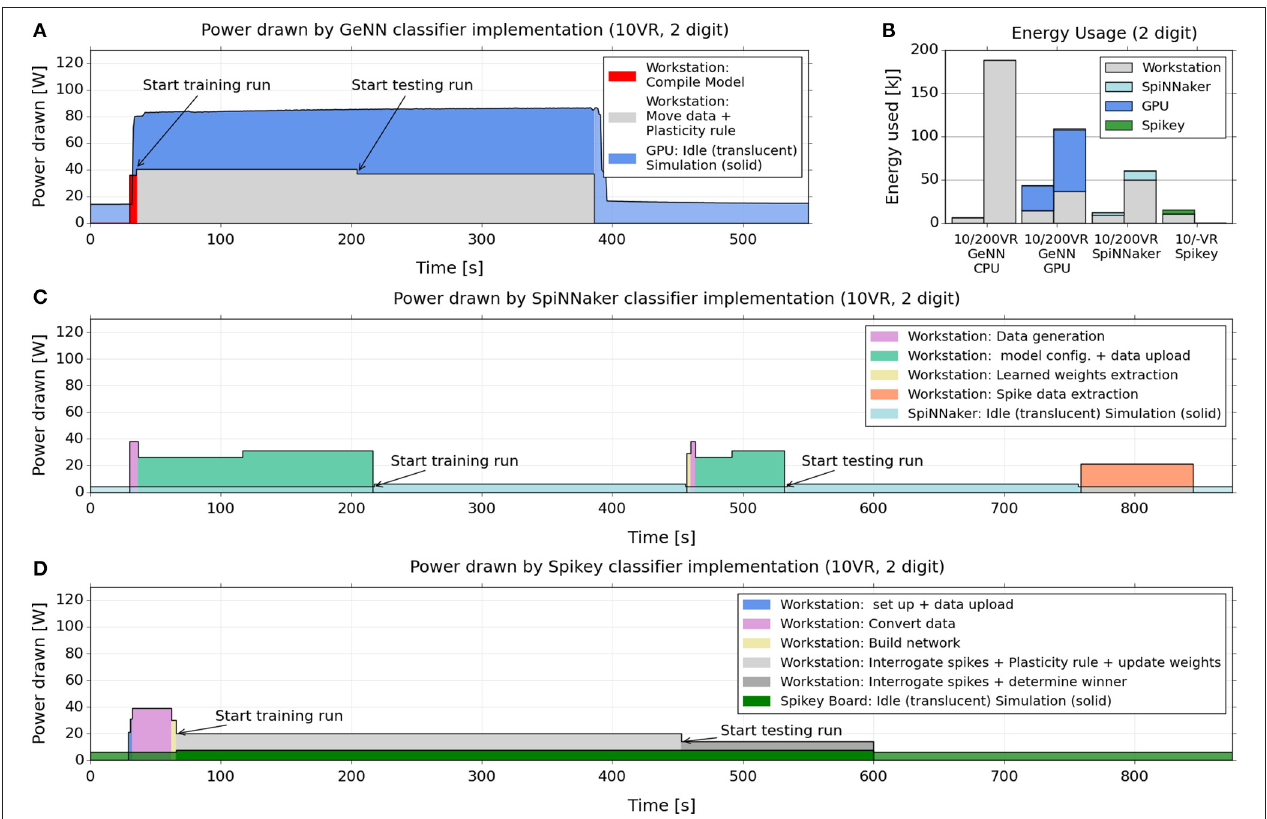
FIGURE 5 | Electrical power drawn and energy used by GeNN, SpiNNaker and Spikey across training and testing when classifying 2 digits with 10VRs. (A,C,D) power consumption across the course of training and testing of a 10VR classifier for 2 MNIST digits (5,7), 1000 samples per digit. The graphs compare the implementations on the GeNN (A) , SpiNNaker (C) , and Spikey (D) platforms. We report the power drawn by the GPU card, the SpiNNaker, and Spikey boards, as well as the power drawn simultaneously by the attached workstation. The latter is reported as the power above the baseline (51 W) drawn by the workstation without GPU card and performing no task. SpiNNaker and Spikey power consumption was measured directly with the inline meter while GPU power draw was obtained via the reporting of the “nvidia-smi” utility (see main text). (B) Energy usage for a 10VR and a 200VR classifier, applied to 2 MNIST digits (5,7), 1000 samples per digit. The readings approximate the total energy (above baseline) used during the training and testing by multiplying the power usage in each stage of the process by its duration. The readings are repeated for the GeNN GPU, SpiNNaker and Spikey (10VR only) platforms as well as for GeNN when set to use the workstation CPU